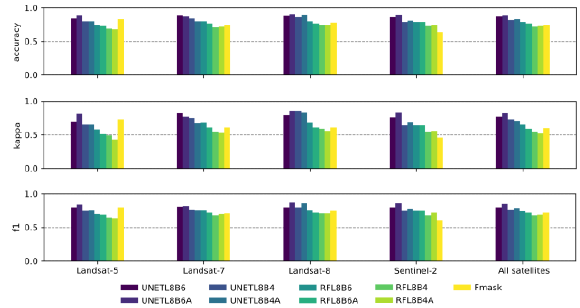
Figure 2. Results for each model grouped by satellite.